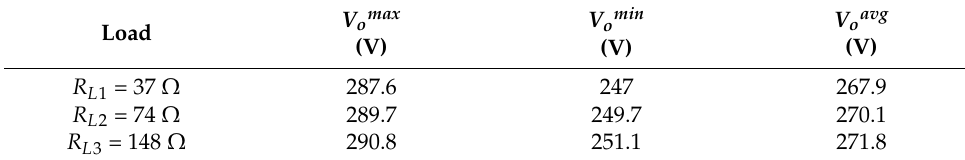
Table 15. CTU output voltage simulation results under unbalanced input voltage.